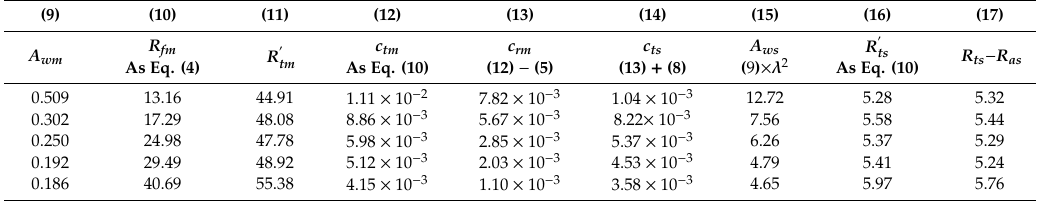
Table 5. Full-scale resistance calculation table based on calculated model resistance and two-dimensional method.